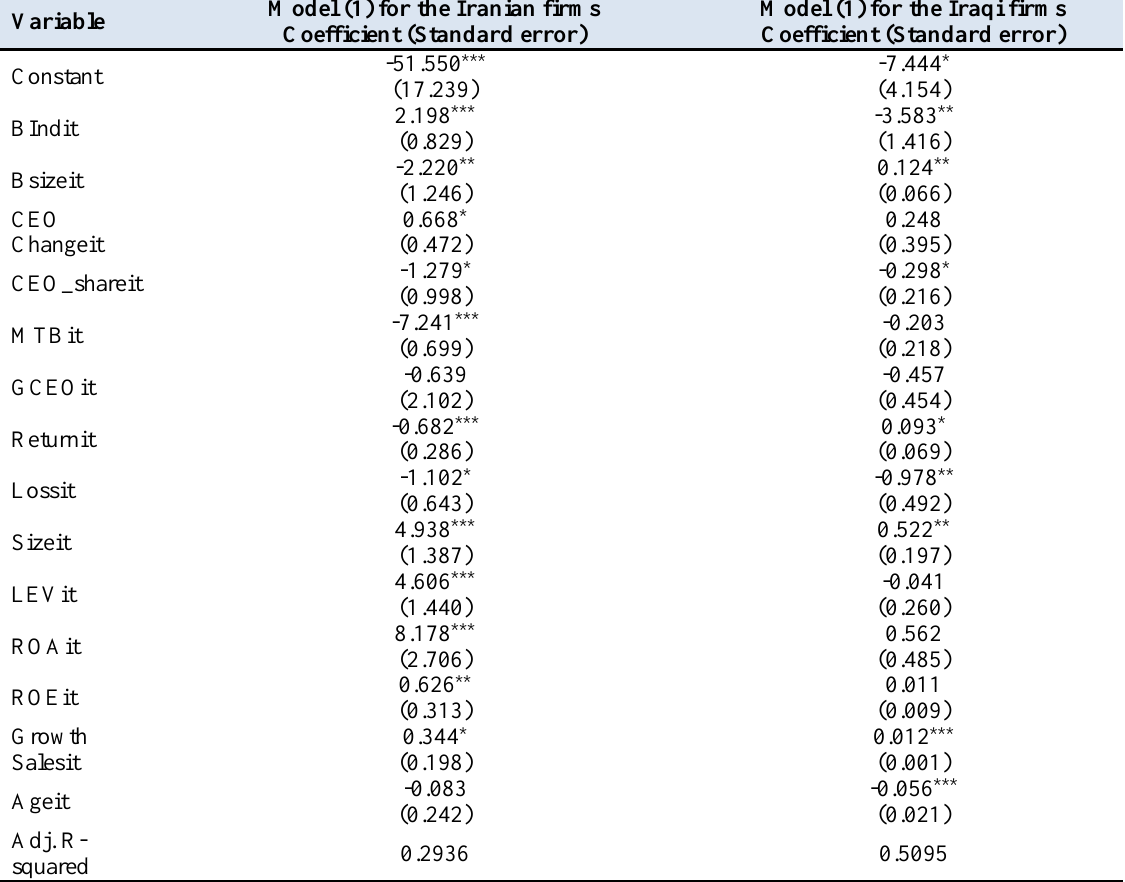
Table 6: The results of model estimation for Iranian